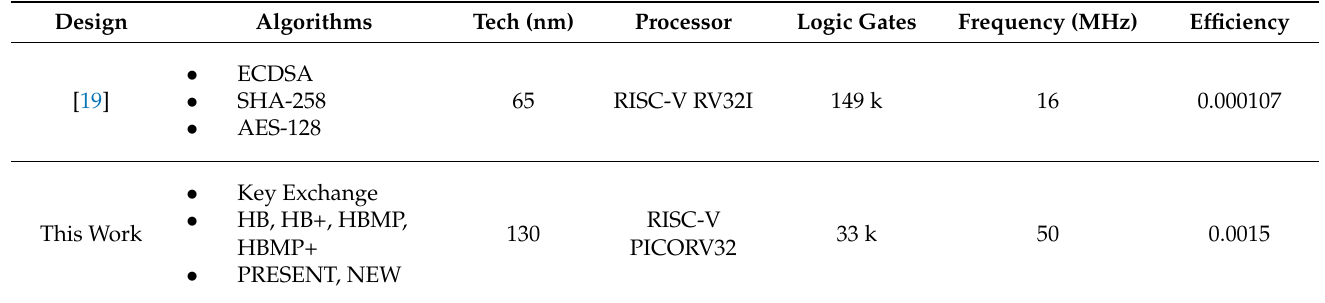
Table 9. Synthesis results for the proposed lightweight cryptographic